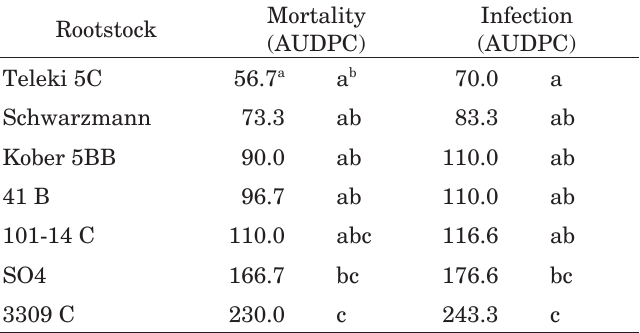
Table 1. Mortality and infection rates from Armillaria mellea , expressed as the Area Under Disease Progress Curve at the fifth year after inoculation (AUDPC), for seven grapevine rootstocks planted in infected substrate (Method A). Rootstock